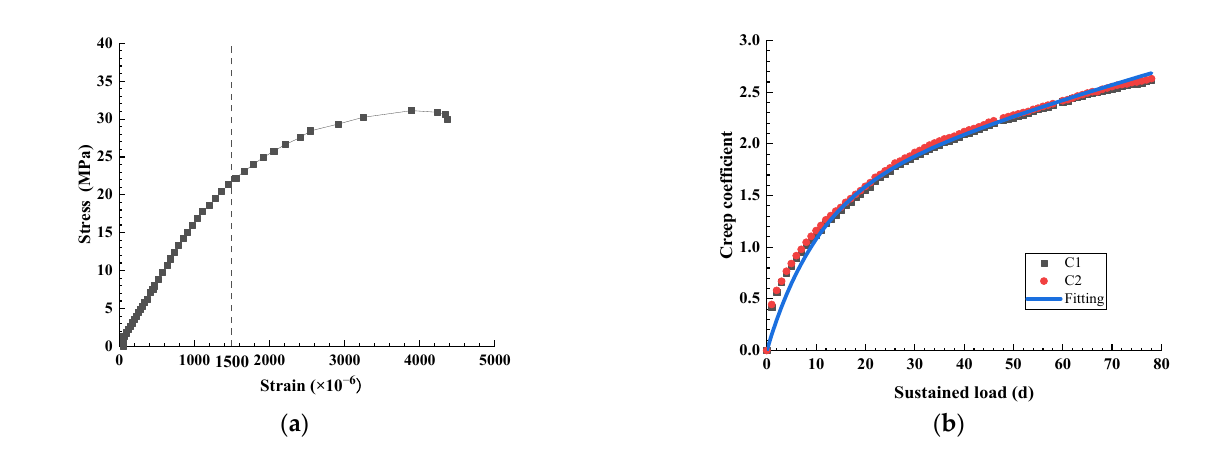
Figure 11. The properties of concrete: ( a ) uniaxial stress–strain and ( b ) the creep curves of the concrete. Table 5. The fitted parameters of the creep model.